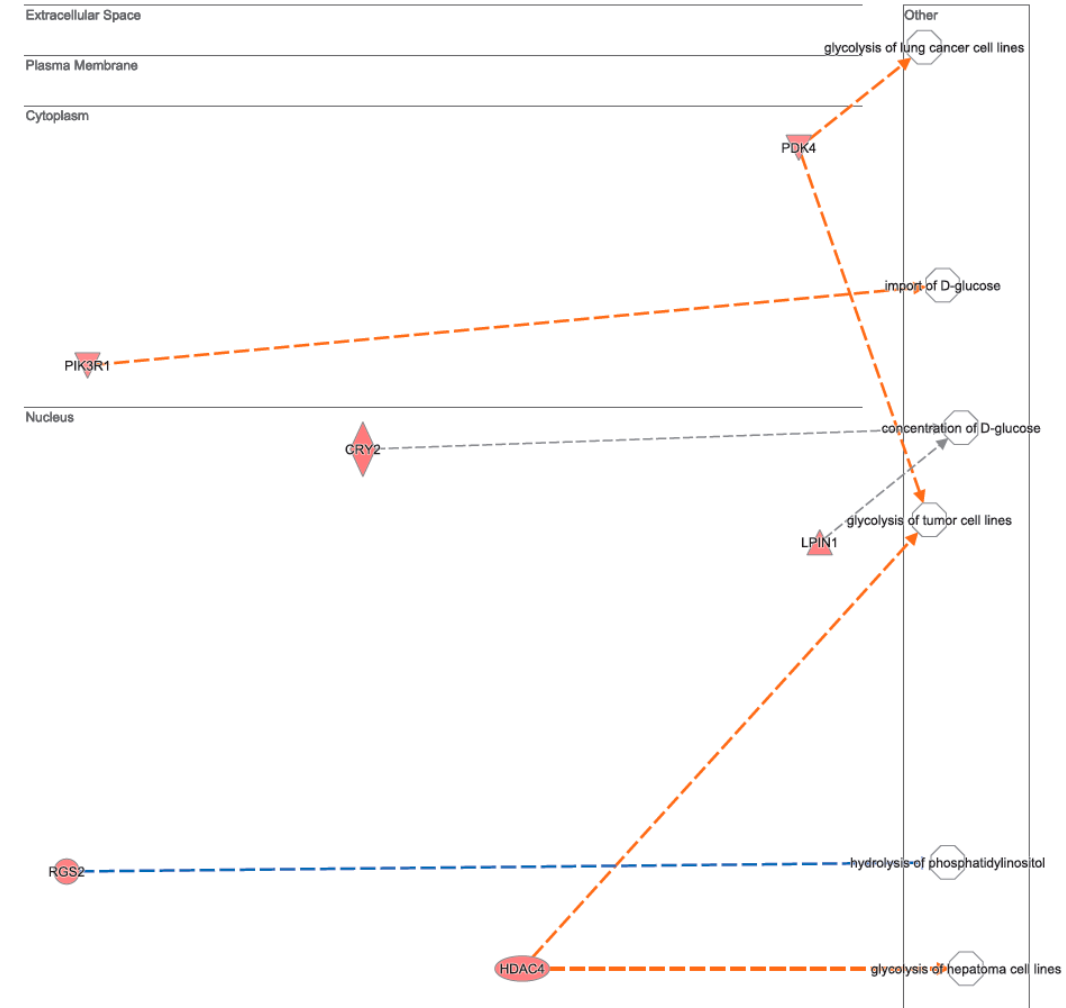
Figure 4. IPA network analysis of the genes differentially expressed between the CTRL and RS groups involved in carbohydrate metabolism. The genes shaded in red are up-regulated in RS compared with the CTRL group. The orange dotted arrows indicate activation, the blue dotted arrows indicate inhibition, and the grey dotted arrows indicate no predicted effect on the downstream biological processes.